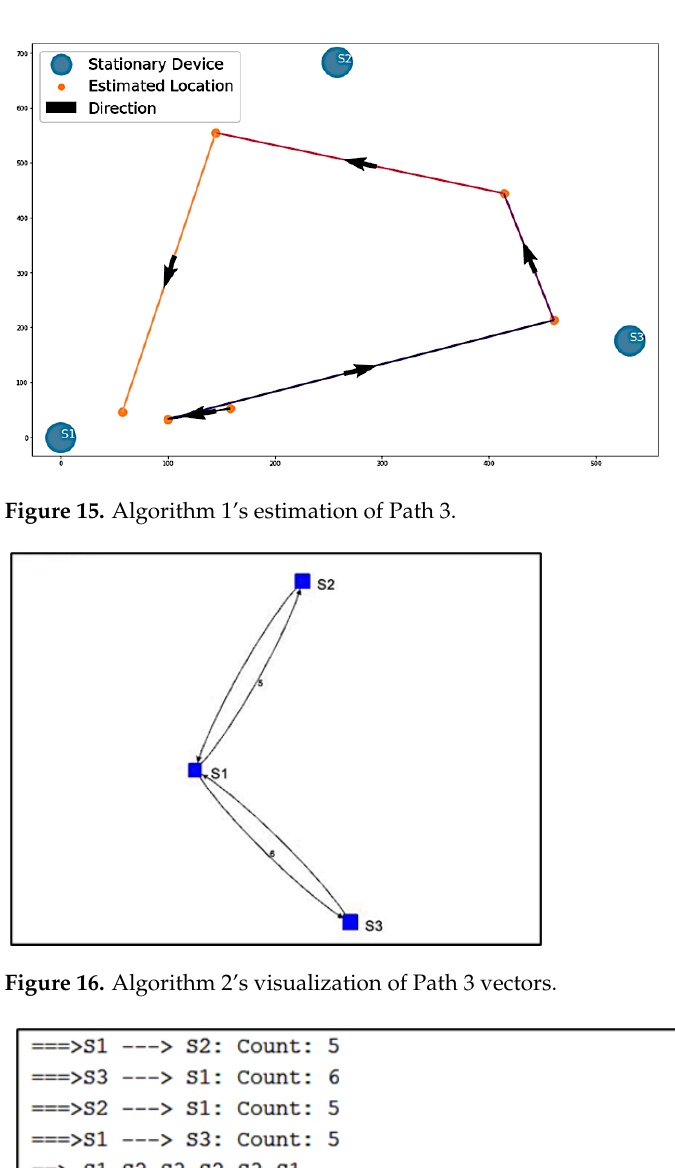
Figure 16. Algorithm 2 ’ s visualization of Path 3 vectors.